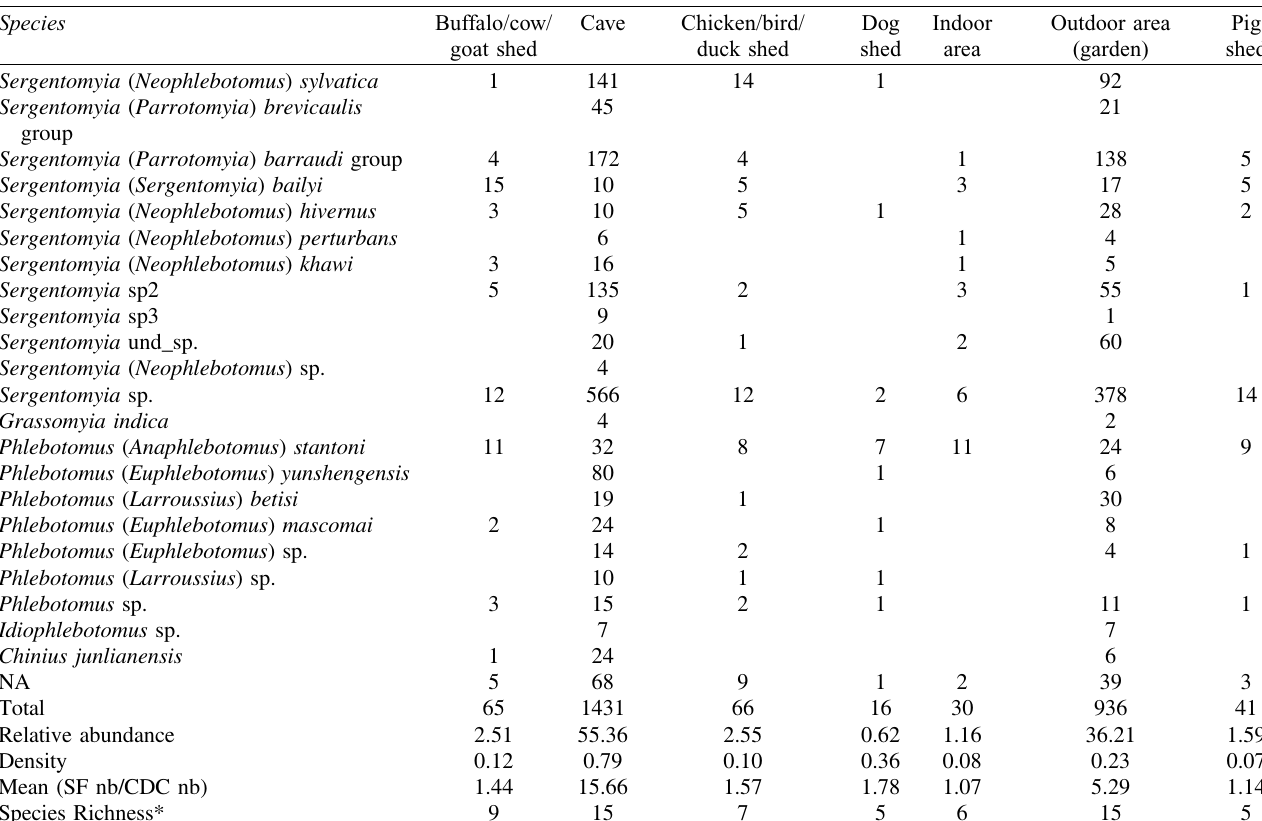
Table 3. Number of specimens per taxon, relative abundance, mean value (number of sand fl ies/number of CDC traps), density and species richness according to different